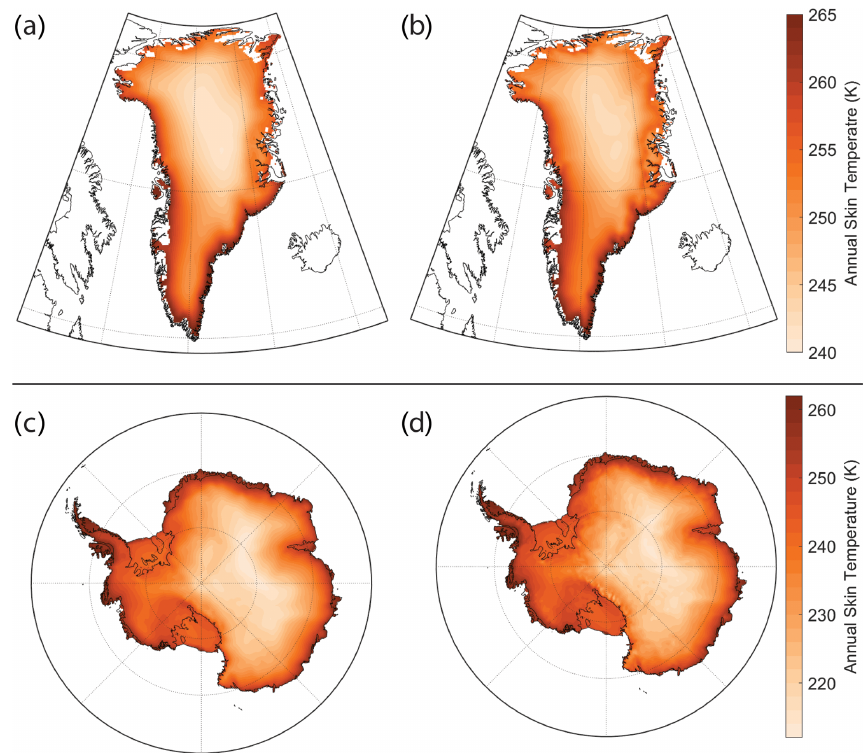
Figure 6. Mean annual skin temperature for the Greenland (a, b) and Antarctic (c, d) ice sheets from MERRA-2 (a, c) and M2R12K (b, d) over their contemporaneous time span (2000–2014). Note the differences in color scale for Greenland and Antarctica.